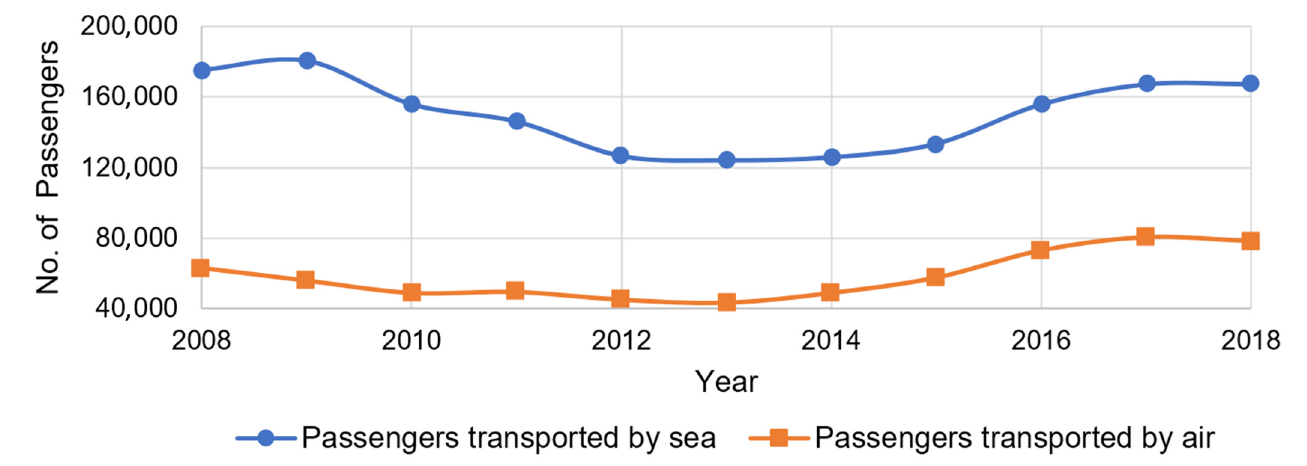
Figure 11. Passengers disembarked in Porto Santo. (Source: Edited by Authors).